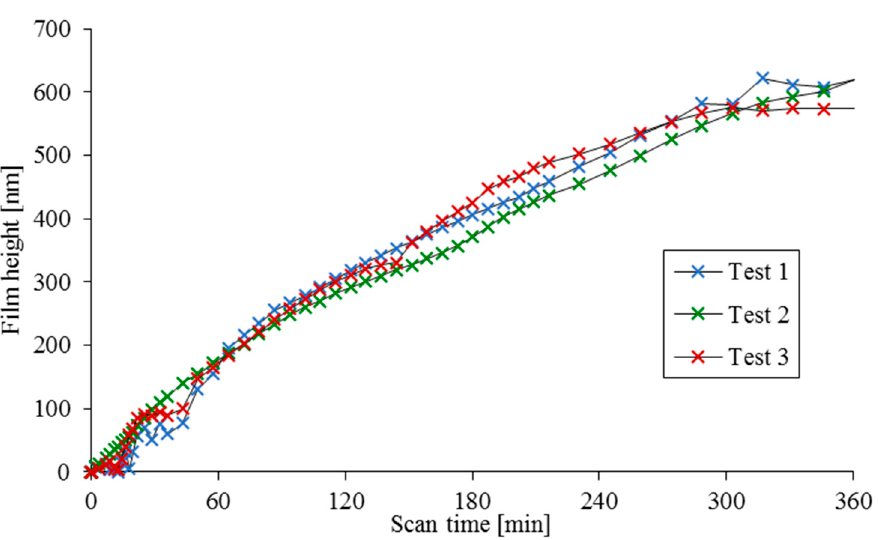
Figure 2. Measured surface height data from three scanned areas on the EN31 steel sample with the base oil containing MoDTC.